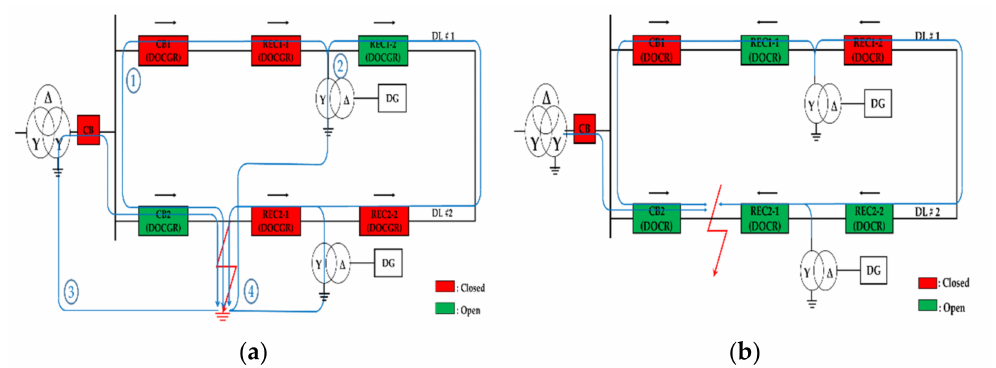
Figure 2. Flow diagram of fault current (phase-to-phase short circuit); ( a ) Setting in the direction of the load side; ( b ) Setting in the direction of the generation